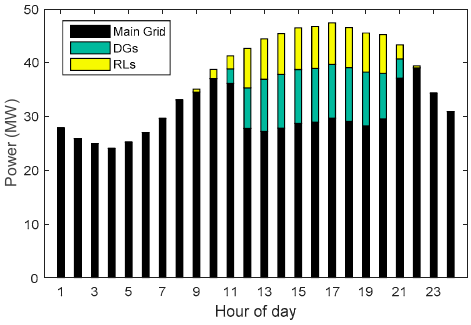
Figure 11. Energy resources scheduling results for Case 7.